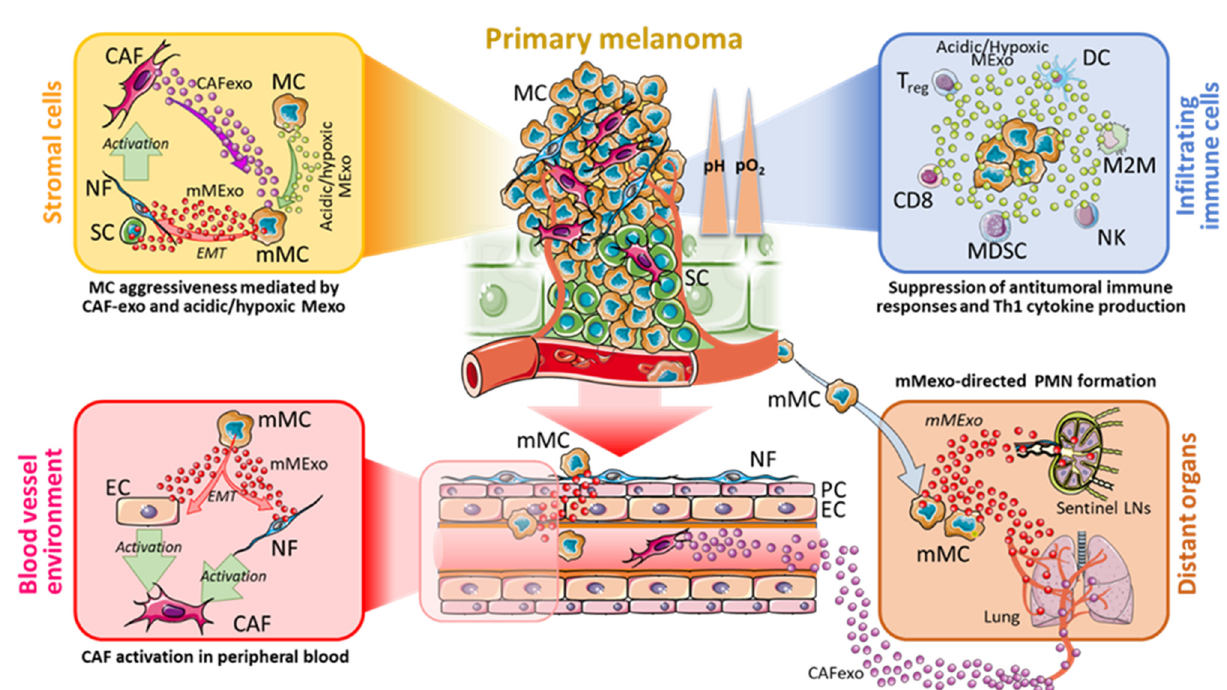
Figure 2. Model of Exosome ‐ based bi ‐ directional crosstalk between CAFs, immune cells and Melanoma. During the development of the primary tumour, CAFs located in the TME release CAFexo which can increase the aggressiveness of MCs. In parallel, MCs in the acidic and hypoxic region (yellow box) can also release acidic and hypoxic Mexo, thus coordinating the generation of mMCs in the acidic and hypoxic regions of melanoma microenvironment, in part via EMT. These mMCs will produce mMexo which, through EMT, do elicit the activation of SCs and NFs into CAFs. In addition, mMCs will migrate into blood vessels and, by releasing mMexo, will contribute to the generation of PMN in distant organs (i.e., lung and LNs), which in turn become educated to receive the migrating mMCs (brown box). In the blood vessel environment (red box) mMCs and CAFs induce ECs and NFs to be activated into CAFs, in part by an EMT ‐ dependent manner. CAFs will release CAFexo which participate in the PMN formation in distant organs, in coordination with mMexo. The acidic Mexo released by MCs will also reach the infiltrating immune cells (light blue box), leading to the activation of MDSCs, M2M and Tregs, and suppression of DCs and NKs. The final effect of such CAF ‐ immune cells ‐ melanoma crosstalk results in the generation of PMNs in distant organs, and the suppression of the anti ‐ tumoural immune responses. CAFexo, CAF ‐ derived exosomes; Mexo, melanoma ‐ derived exosomes; mMexo, metastatic melanoma ‐ derived exosomes; LNs, lymph nodes; NF, normal fibroblast; MC, melanoma cell; mMC, metastatic melanoma cell; EMT, Epithelial ‐ to ‐ mesenchymal transition; SC, skin cell; PC, pericyte; EC, endothelial cells; DC, dendritic cell; M2M, M2 ‐ differentiated macrophage; NK, natural killer cell, Treg, T regulatory lymphocyte; CD8, CD8+ T lymphocyte; MDSC, myeloid ‐ derived suppressor cell; PMN, pre ‐ metastatic niche.